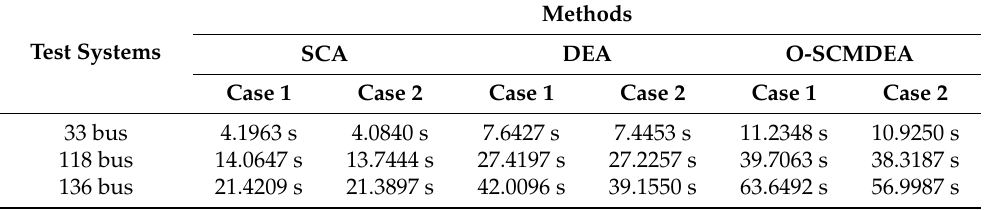
Table 19. Comparison of the simulation time for Scenario I applied to the studied test